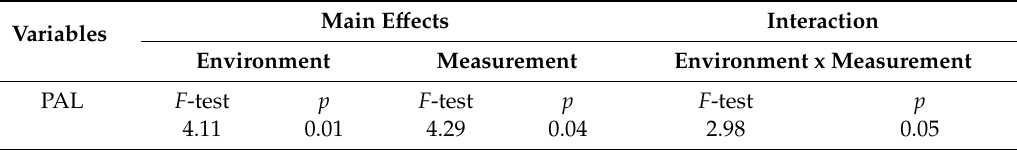
Table 1. Factorial analysis of variance for repeated